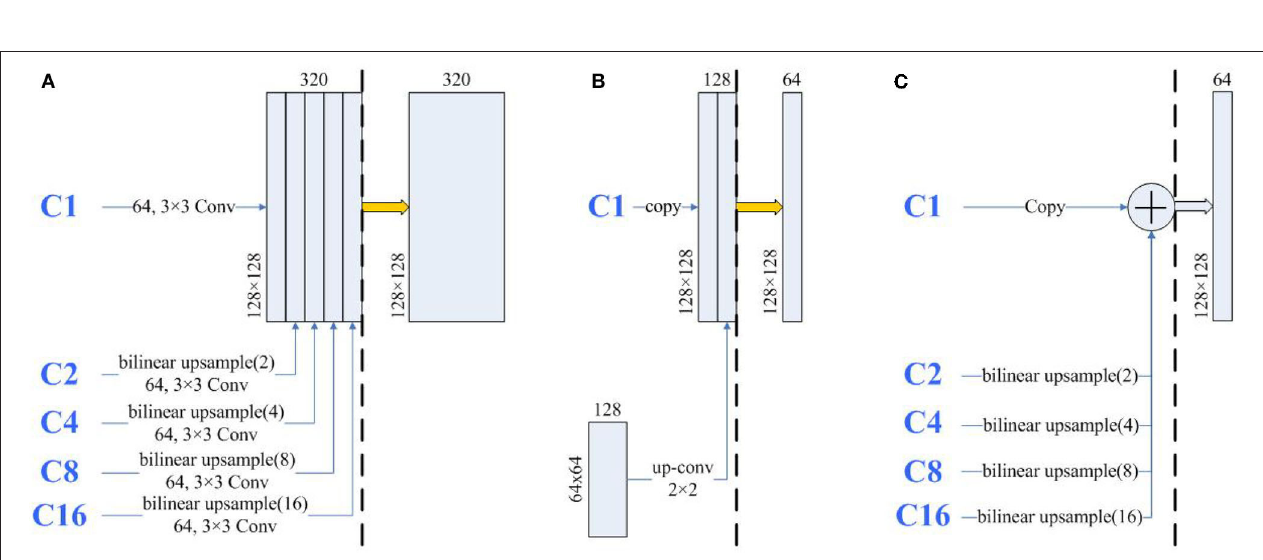
FIGURE 6 | The architecture of the same part of UNet3+ and U-Net. The thick yellow arrows represent 3 × 3 convolutions and the thick blue arrows represent Ghost modules. The three sub-networks are divided into left and right parts by black dashed lines. (A) A part of UNet3+, (B) A part of U-Net, and (C) A part of-Half-UNet.